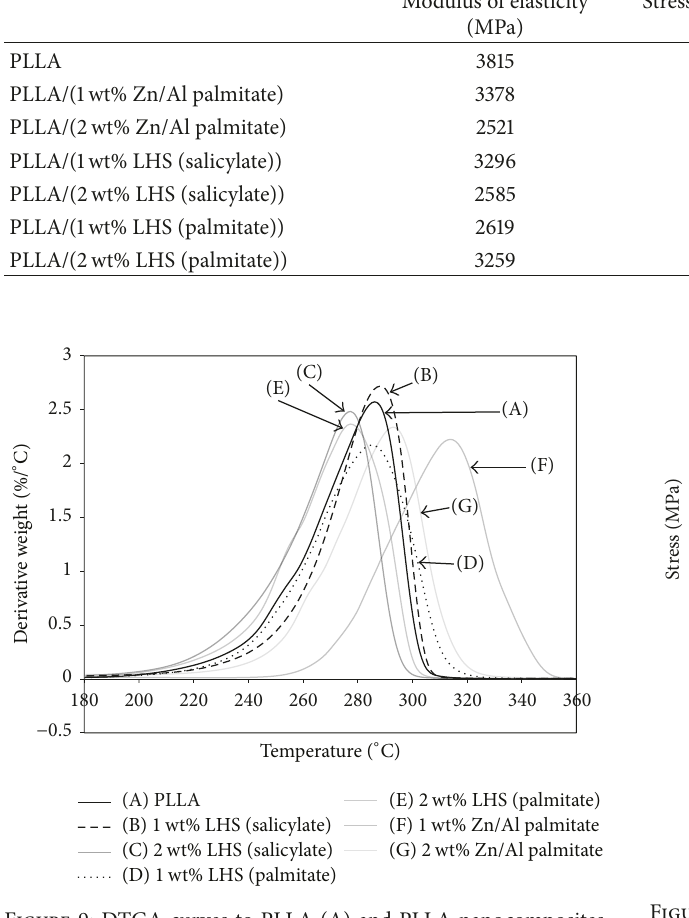
Figure 9: DTGA curves to PLLA (A) and PLLA nanocomposites (B–G).